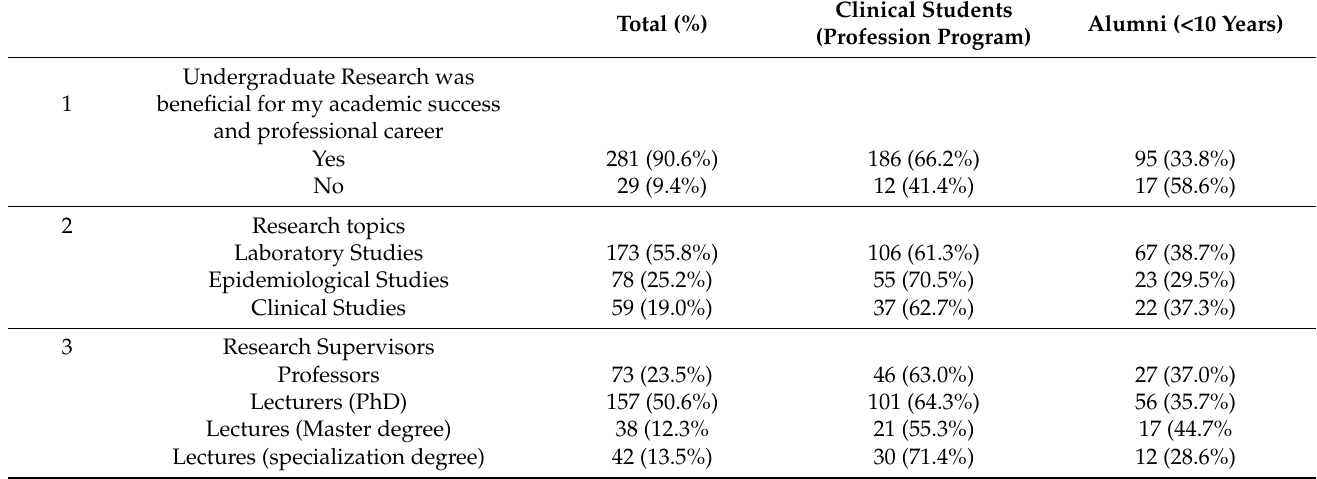
Table 2. Background of Undergraduate